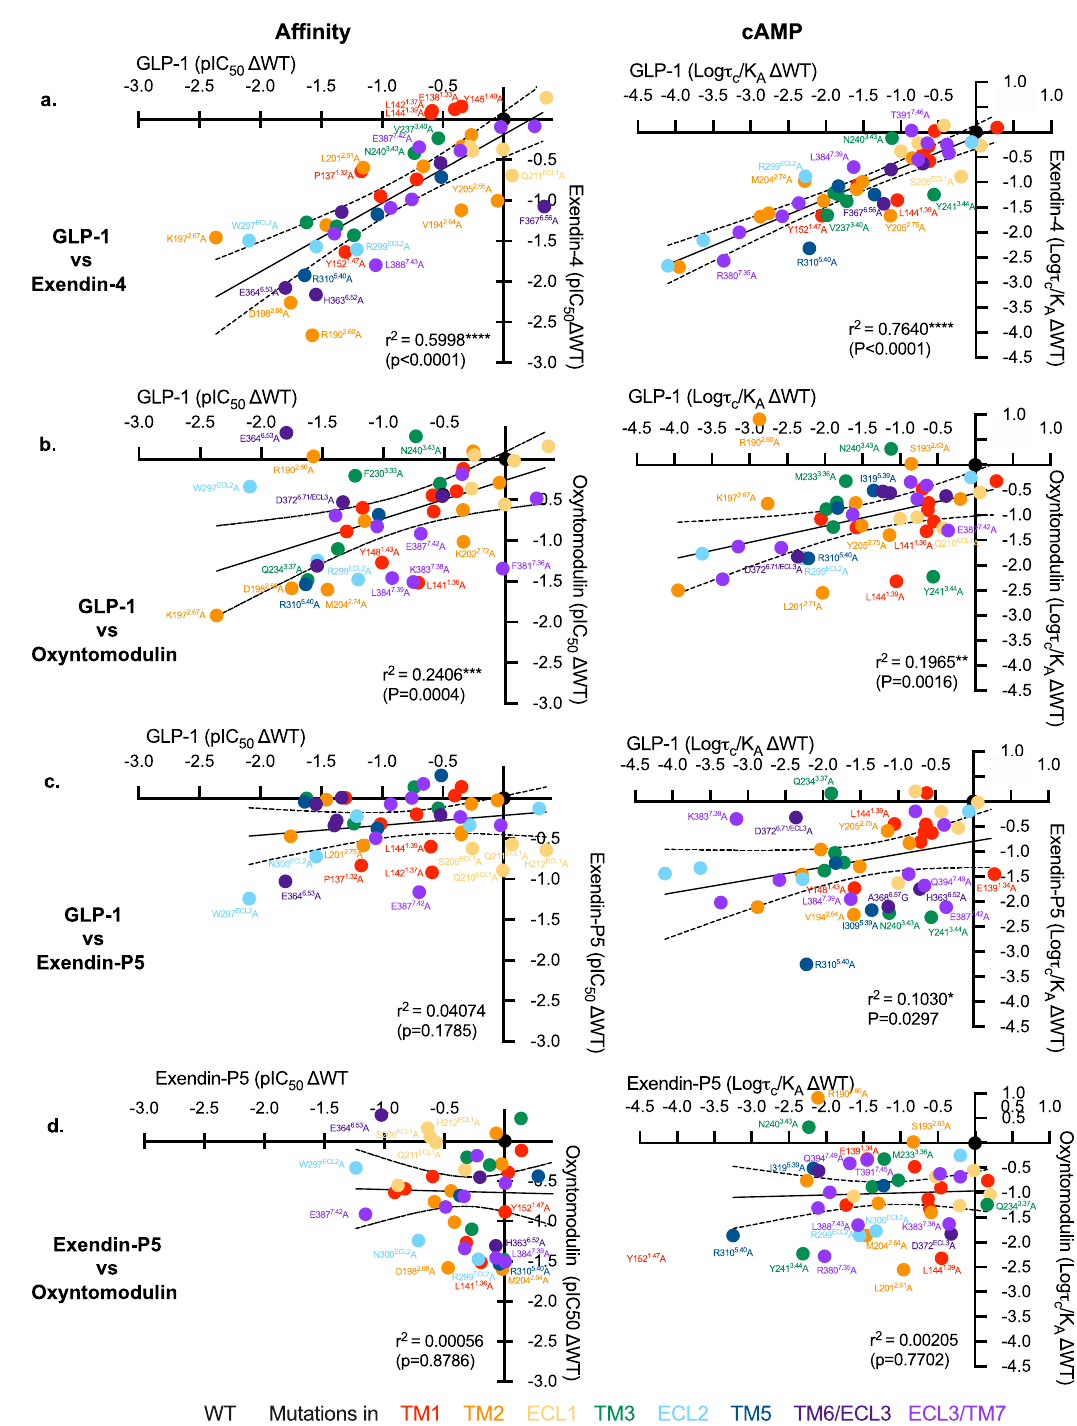
Fig. 5 Correlation plots of the changes in peptide af fi nity and ef fi cacy for TMD mutations relative to the wildtype receptor. a GLP-1 vs. exendin-4; b GLP-1 vs. oxyntomodulin; c GLP-1 vs. Exendin-P5; d Exendin-P5 vs. Oxyntomodulin. Data were fi t by linear regression and Pearson correlations ( r ) were determined and squared ( r 2 ), and the P value was calculated using a two-tailed critical t value analysis in Prism 9. The line of regression and 99% con fi dence intervals are displayed. Mutations are coloured relative to the receptor TM or ECL that they are located as indicated in the legend. Mutant receptors that fall outside of the 99% con fi dence intervals are labelled. Source data are provided in the Source Data fi